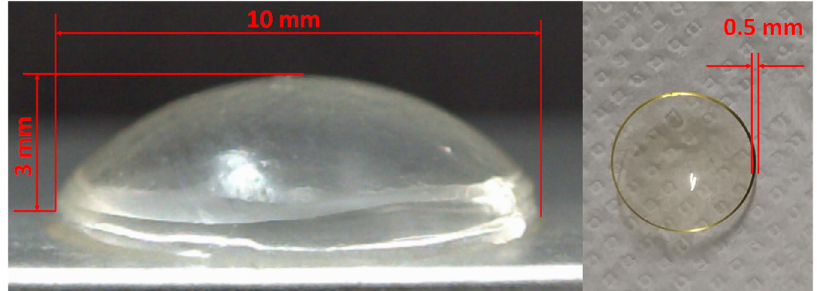
Figure 2. Photograph of the final collagen drug carrier with dimensions measured after drug saturation and formation of a crosslinked barrier on the surface.